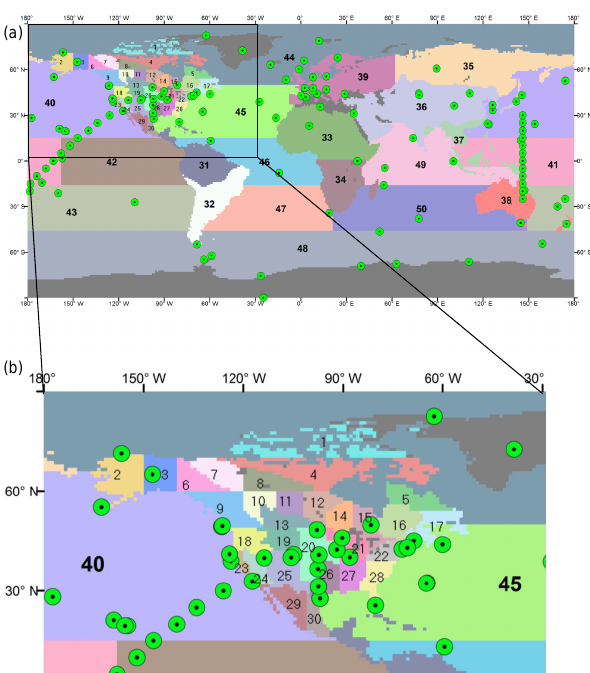
Figure 1. (a) A nested inversion system with 30 regions for North America and 20 regions for the remainder of the globe. The 210 measurement sites are indicated as circles. (b) An enlarged portion for North